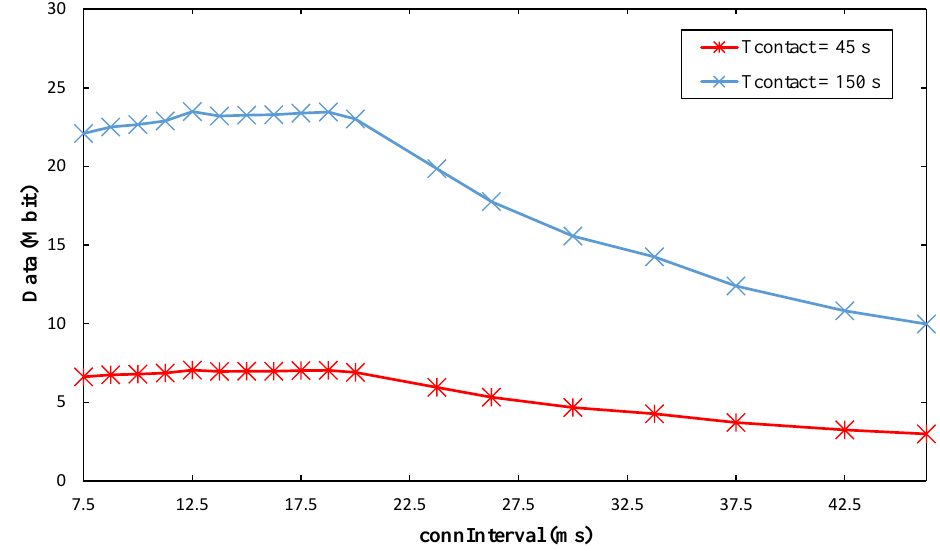
Figure 23. Maximum measured amount of collected data per contact interval, as a function of connInterval , for T contact values of 45 s and 150 s.